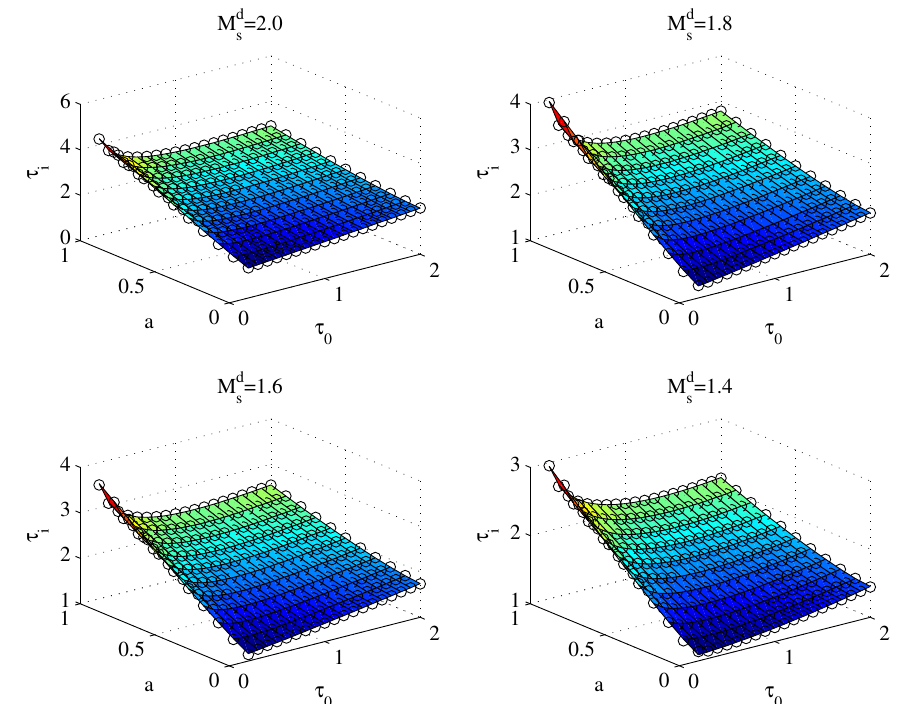
Figure 2. Calculated and approximated optimal τ i in the servo mode.